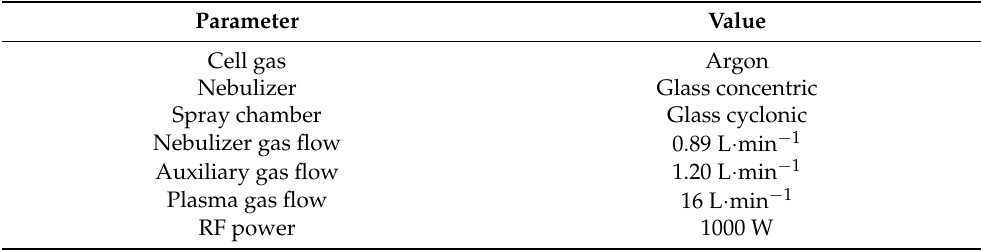
Table 1. NexION300Q instrumental